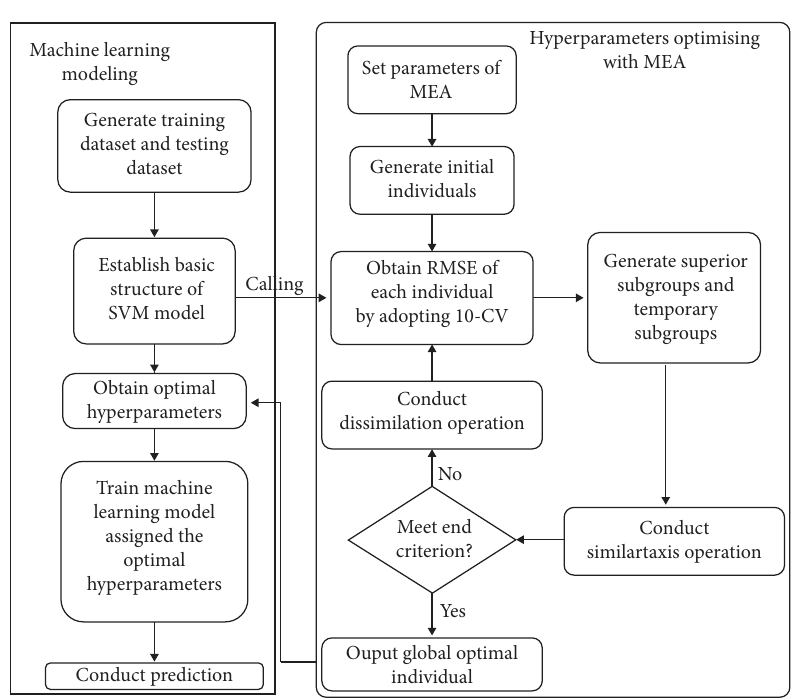
Figure 3: The flow chart of machine learning modelling with MEA